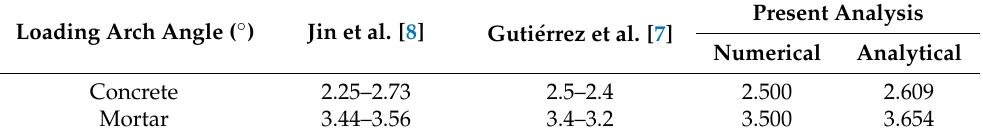
Table 2. Predicted indirect tensile strength σ t (MPa) compared to [7,8] (2 α = 20 ◦